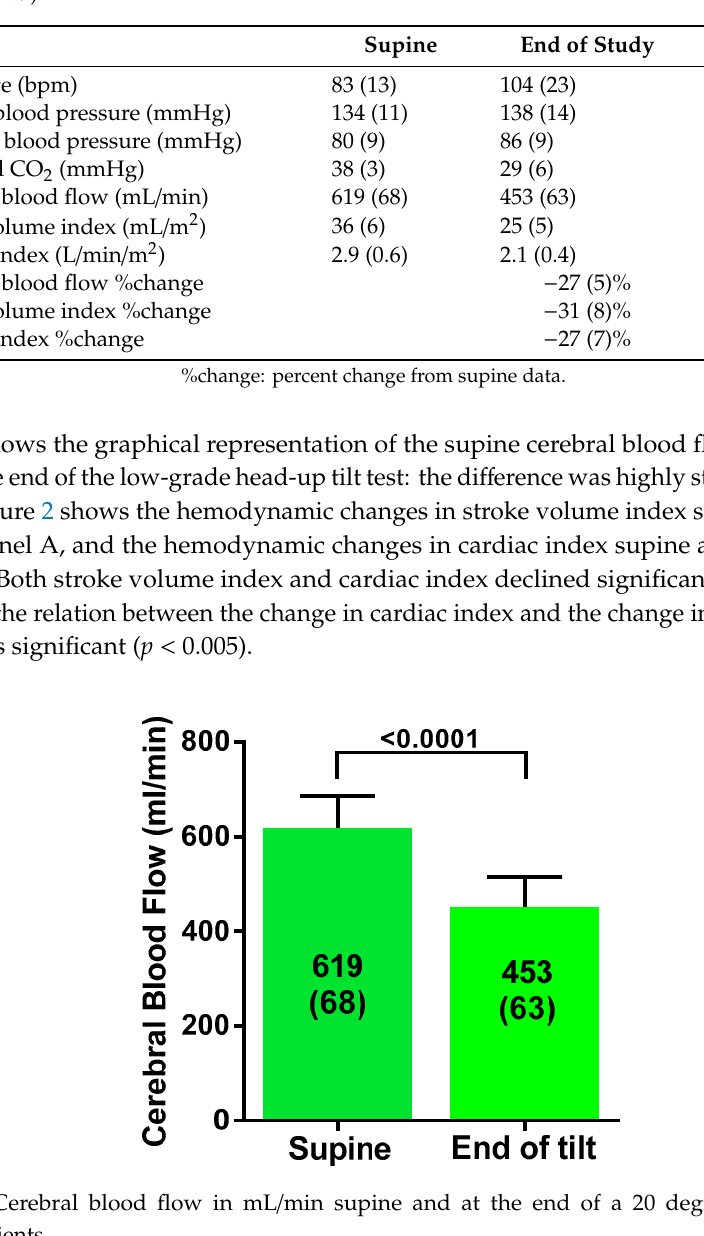
Table 1. Tilt table test data of severe myalgic encephalomyelitis/chronic fatigue syndrome (ME/CFS) patients (n = 19).